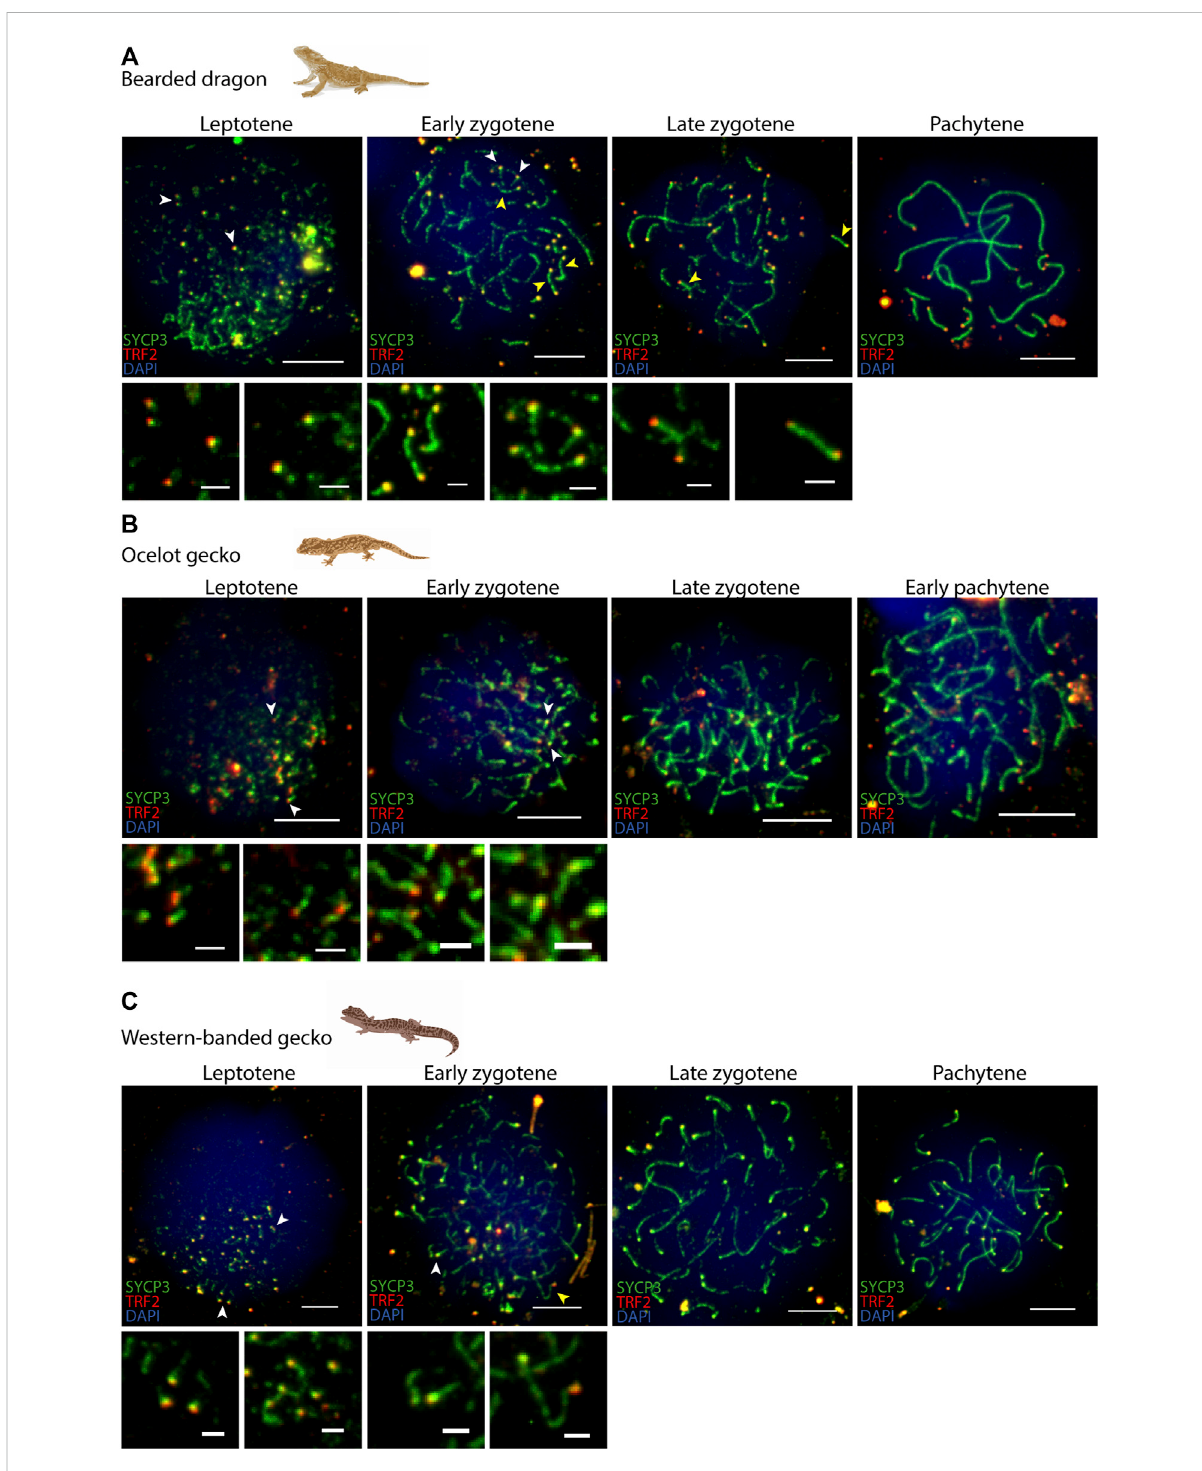
FIGURE 4 Telomere dynamics during prophase I. Spermatocyte spreads labelled with antibodies against SYCP3 (green) and TRF2 (red), counterstaining the DNA with DAPI (blue) for (A) the bearded dragon, (B) the ocelot gecko and (C) the western banded gecko. Scale bar: 10 μ m and 2 μ m (insets). White arrowheads: telomeres from whichSC is beginning to assemble. Yellow arrowheads:completely associated micro-chromosomes (i.e., lateral elements of the SC completely assembled between both telomeric ends).